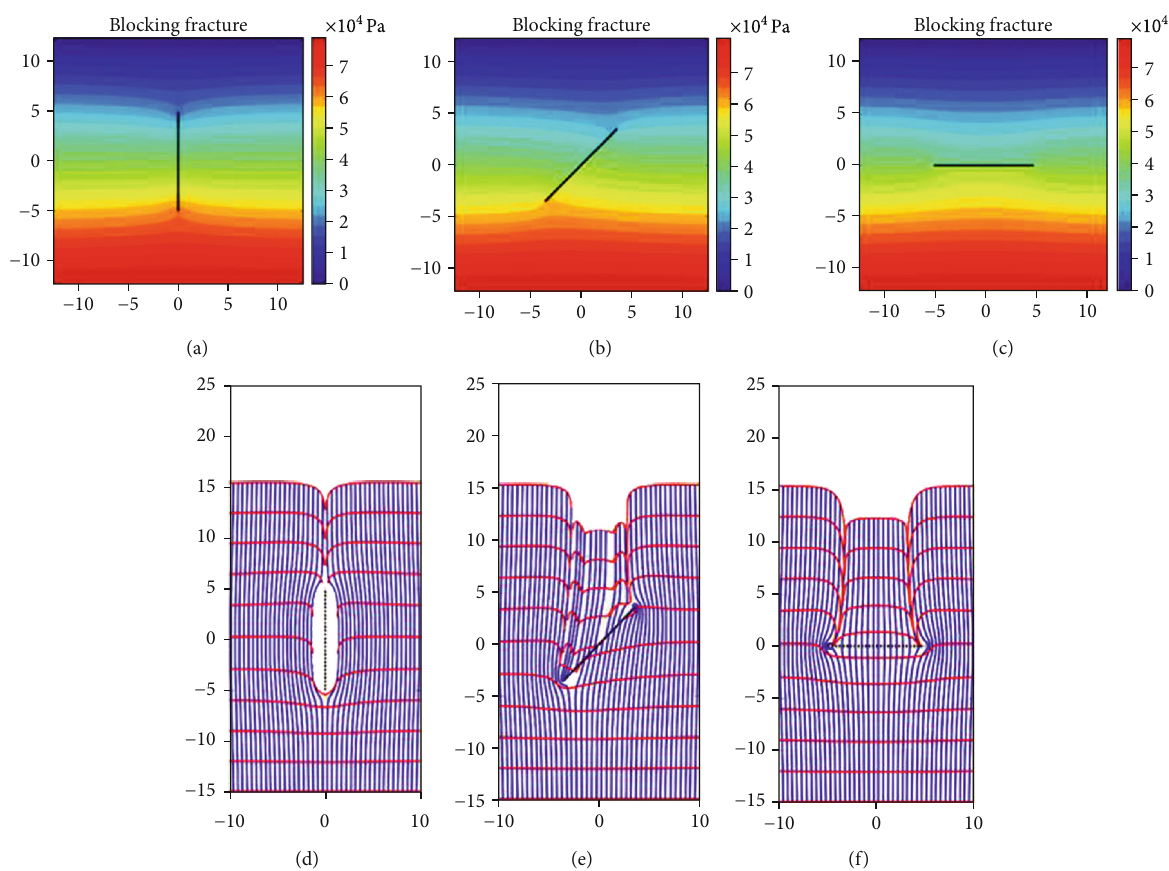
Figure 10: (a, b, and c) Pressure contours (in Pa) for cemented fractures with the same properties as Case A (Figure 7(a), Table 4) except for e ff ective fracture strength, which has a value of − 9 : 6 × 10 − 7 m 4 /s . The natural fractures are oriented at an angle of (a) 0 ° , (b) 45 ° , and (c) 90 ° , with respect to the far- fi eld fl ow. (c, d, and e) Particle paths and TOFCs for the corresponding cases in (a), (b), and